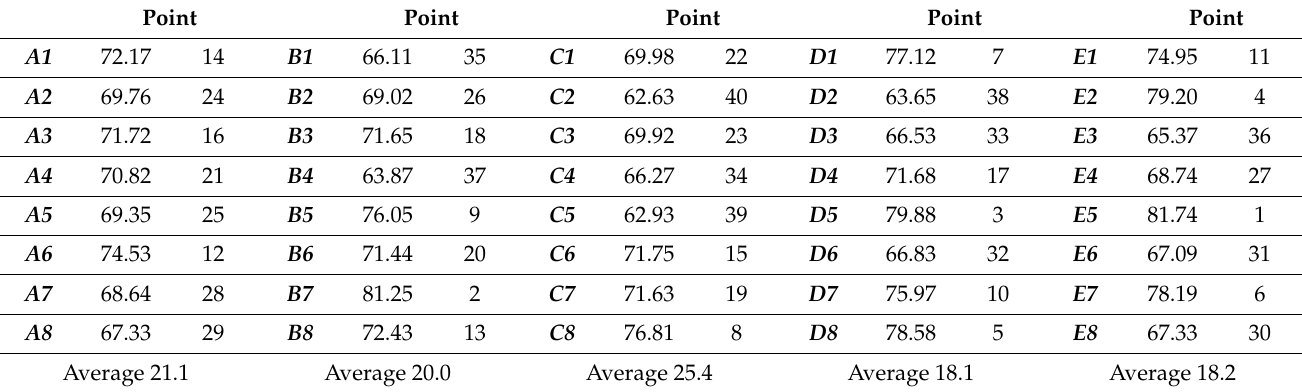
Table 7. Improvement ratio indices on cylinders manufactured with different technologies for R z .